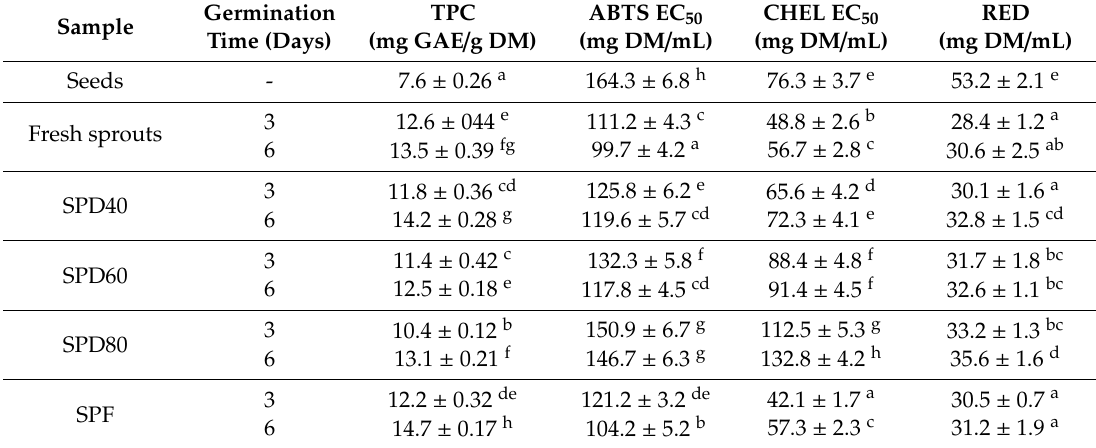
SPD40, SPD60 and SPD80—sprouts air dried at 40, 60 and 80 ◦ C, respectively, SPF—freeze-dried sprouts, TPC—total phenolics content, ABTS—antiradical activity, CHEL—chelating power, RED—reducing power. Means with di ff